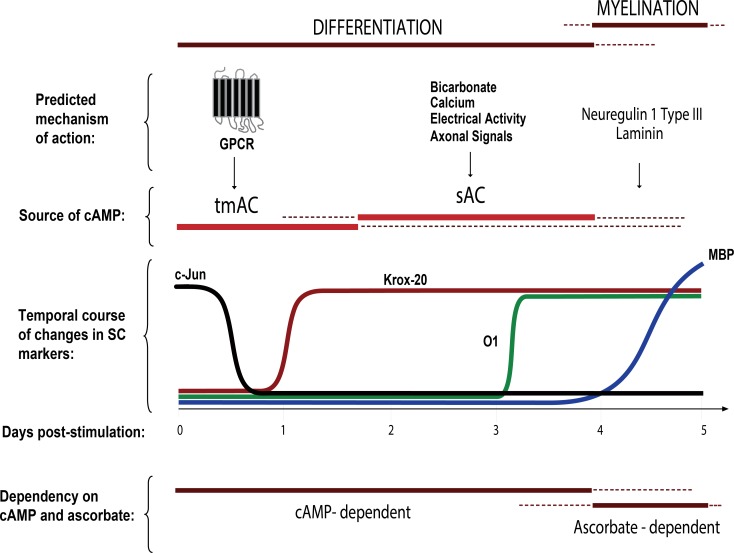
Requirement of cAMP signaling restricts the onset of myelination.Our cell culture studies revealed a crucial role for GPCR-sensitive and GPCR-insensitive sources of cAMP (namely tmAC and sAC) in driving SC differentiation into an O1 phenotype, a stage that precedes MBP expression and the formation of myelin sheaths. For practical purposes, we selected the markers Krox-20, O1 and MBP as phenotypic indicators of the early, mid-term and later stages of differentiation, respectively. We propose a mechanistic model that predicts an orderly requirement of signals from activated Gαs-coupled GPCRs (e.g. Gpr126), sAC (e.g. electrical activity, bicarbonate, and axonal signals), axon contact (e.g. neuregulin type III) and/or basal lamina components (e.g. laminin) prior to the initiation of myelin membrane wrapping. Data also suggests that sAC activation in SCs may depend on yet-to-be-identified axonal/neuronal factors.